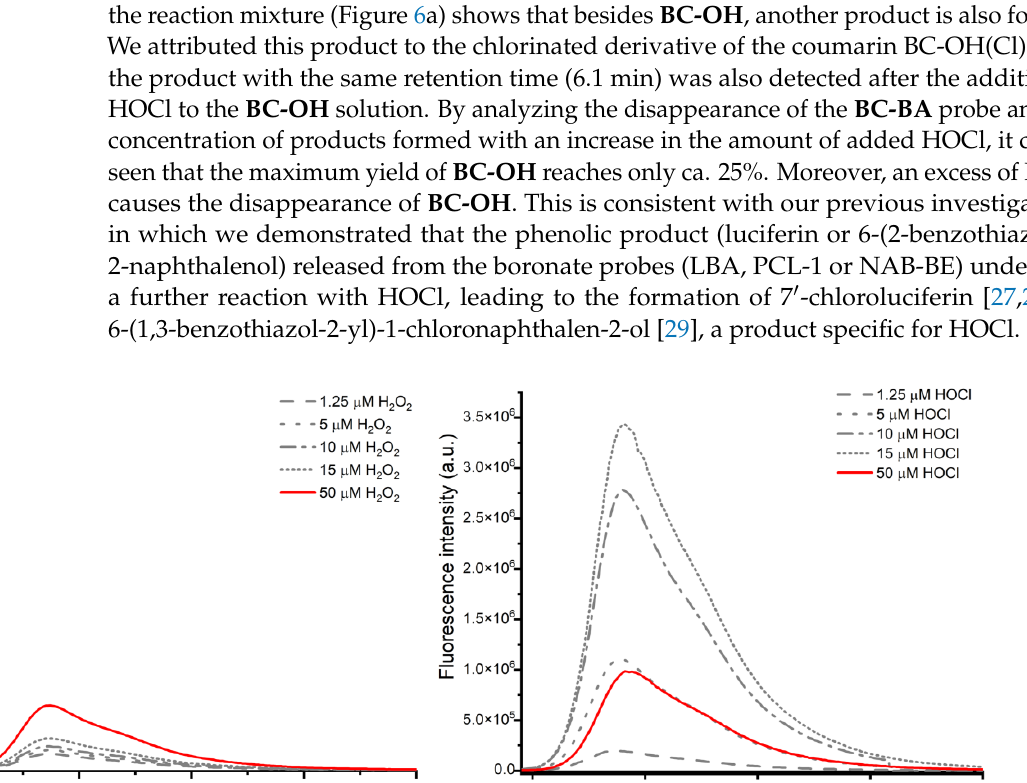
Figure 4. ( a ) Kinetic profiles of product formation during the oxidation of probes BC-BA and CBA (5 µM each) by H 2 O 2 (5 mM). Experiments were repeated three times independently. Representative result displayed; ( b ) HPLC traces of the BC-BA probe (20 µM) before and after addition of H 2 O 2 (20 mM).